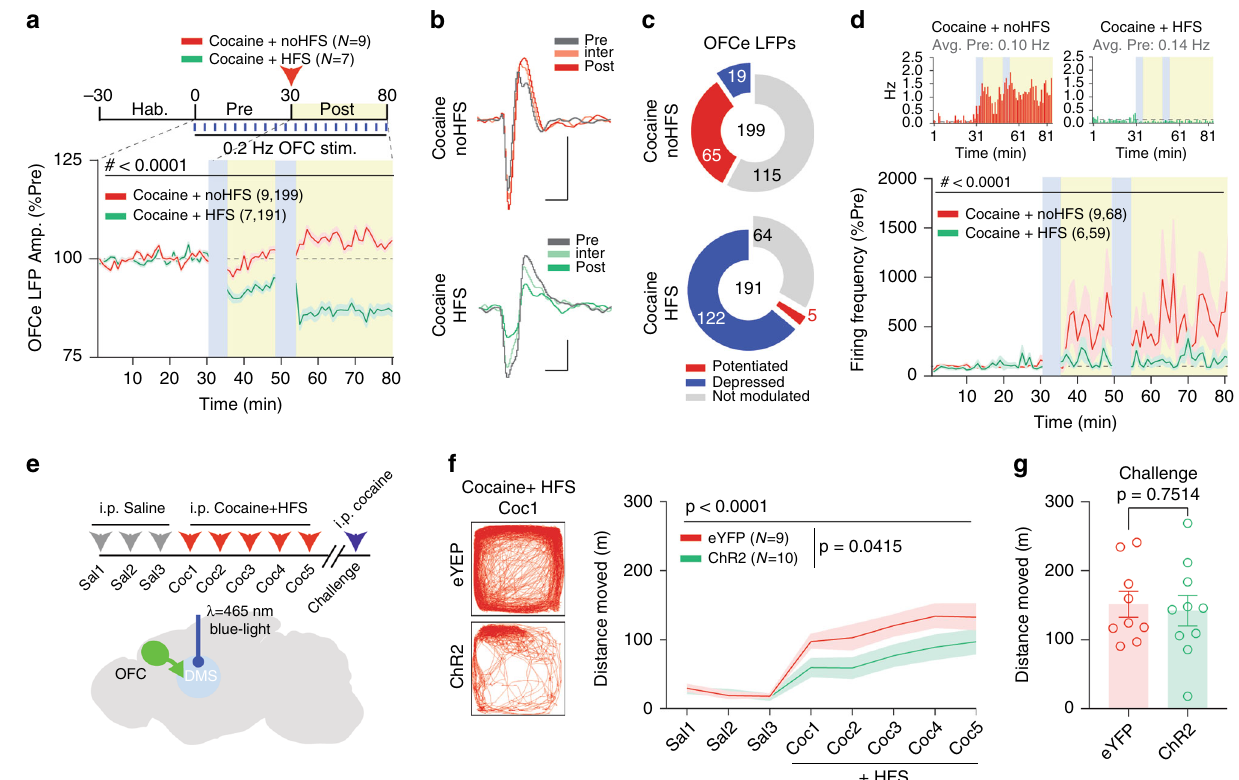
Fig. 7 HFS overpowers cocaine-dependent OFC-DMS potentiation and attenuates hyperactivity. a Time-course of norm. OFCe LFP responses in mice exposed to cocaine before high-frequency stimulation (HFS) or no HFS (RM two-way ANOVA; time main effect: F (69,26772) = 23.08, p < 0.0001; treatment main effect: F (1,388) = 130.3, p < 0.0001; time Χ treatment interaction: F (69,26772) = 71.29, p < 0.0001). b Representative OFCe LFP traces. Scale bar: 20 ms, 50 μ V. c Pie-charts reporting the number of signi fi cantly potentiated or depressed and non-modulated OFCe LFP responses. d Time-course of norm. fi ring frequency of striatal multi-units in mice exposed to cocaine before HFS or no HFS (RM two-way ANOVA; time main effect: F (73,9125) = 2.499, p < 0.0001; treatment main effect: F (1,125) = 2.106, p = 0.1492; time Χ treatment interaction: F (73,9125) = 1.756, p < 0.0001). Top: representative rate histograms. e Experimental schematics. f Mouse movement tracking examples during the fi rst cocaine exposure (Coc 1) and distance moved during sensitization paradigm for eYFP and ChR2 infected mice (RM two-way ANOVA; time main effect: F (7,119) = 28.91, p < 0.0001; virus main effect: F (1,17) = 4.861, p = 0.0415; time Χ virus interaction: F (7,119) = 2.009, p = 0.0595). g Distance moved upon cocaine challenge (unpaired two-tailed t -test: t (17) = 0.3219). Data are represented as mean ± SEM. N , n indicate number of mice and OFCe LFPs or units included in the